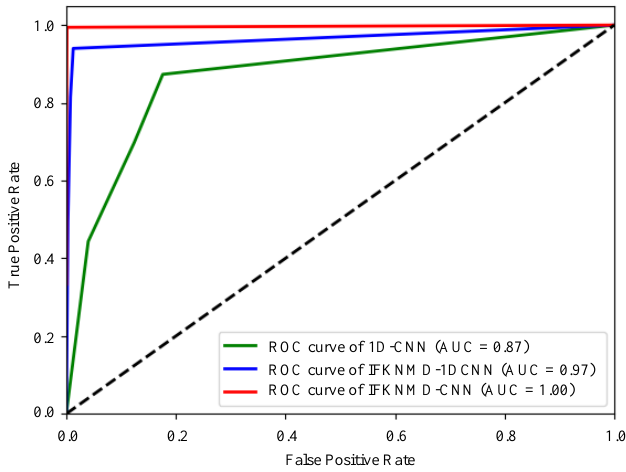
ROC curve of 1D-CNN (AUC = 0.87) ROC curve of IFKNMD-1DCNN (AUC = 0.97) ROC curve of IFKNMD-CNN (AUC = 1.00)